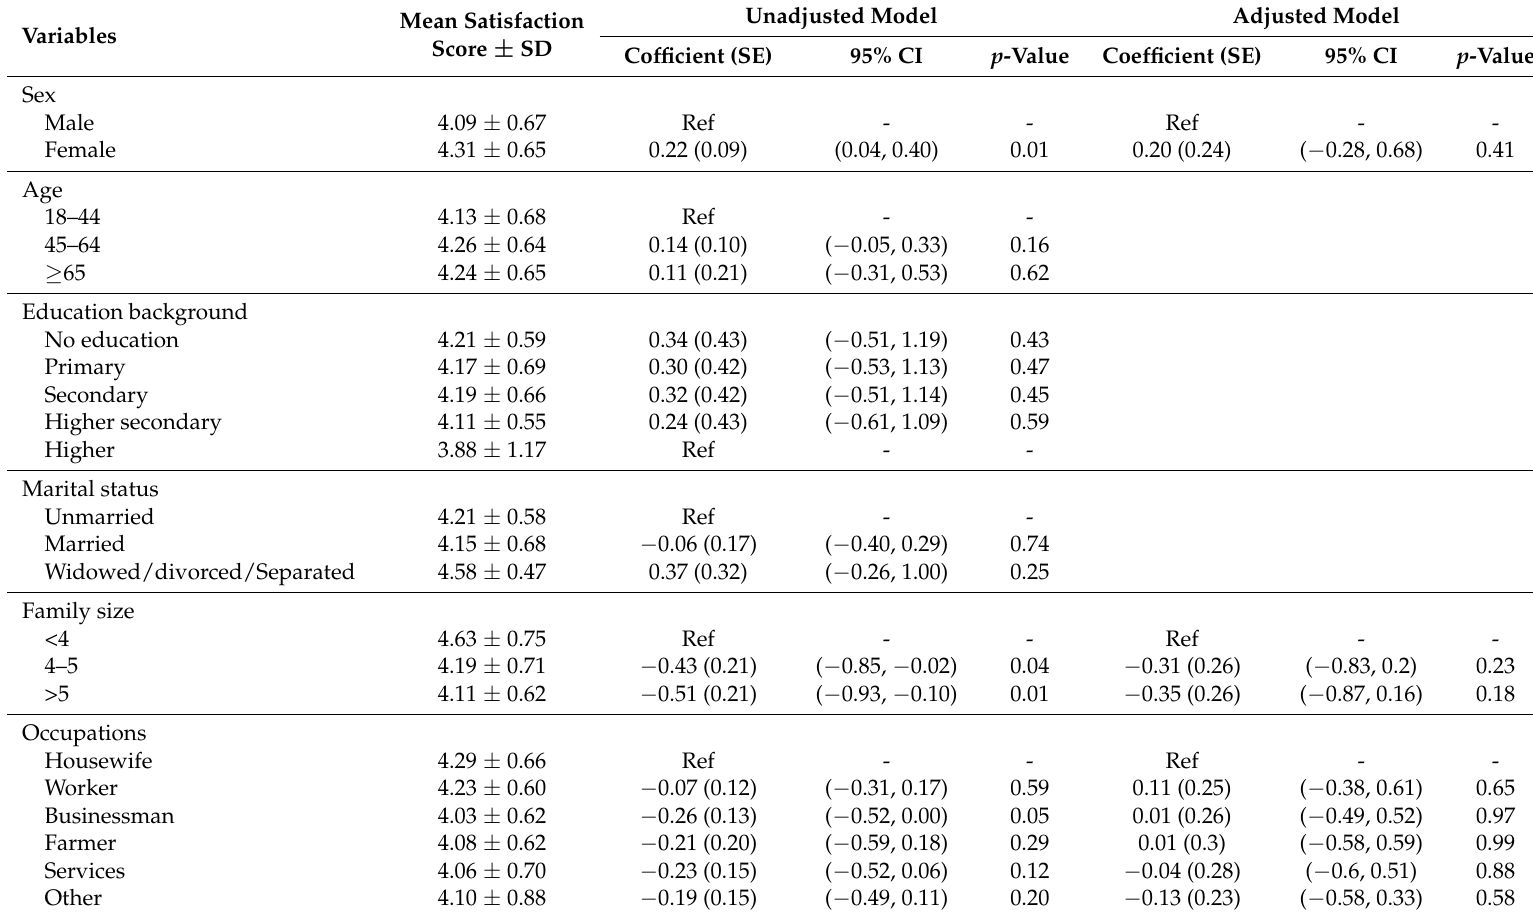
Table 4. Distribution of health services provision-related average satisfaction score on self-financed health scheme across the beneficiary characteristics.